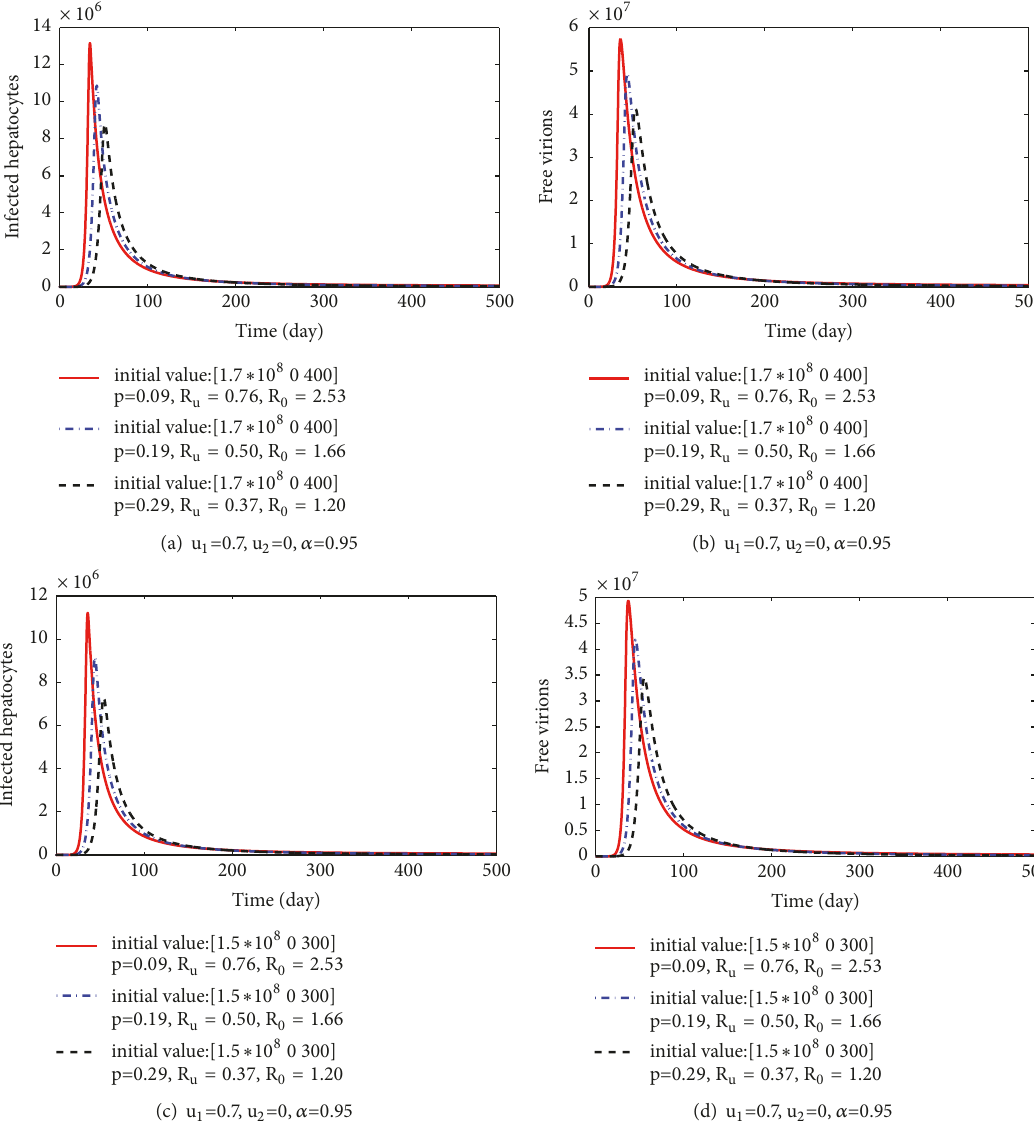
indicate that the value of 𝛼 is an important factor for the peak of disease